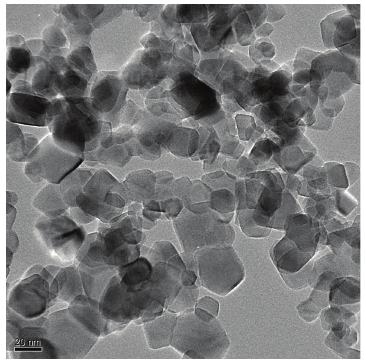
Figure 1: TEM image of nano-TiO 2 .